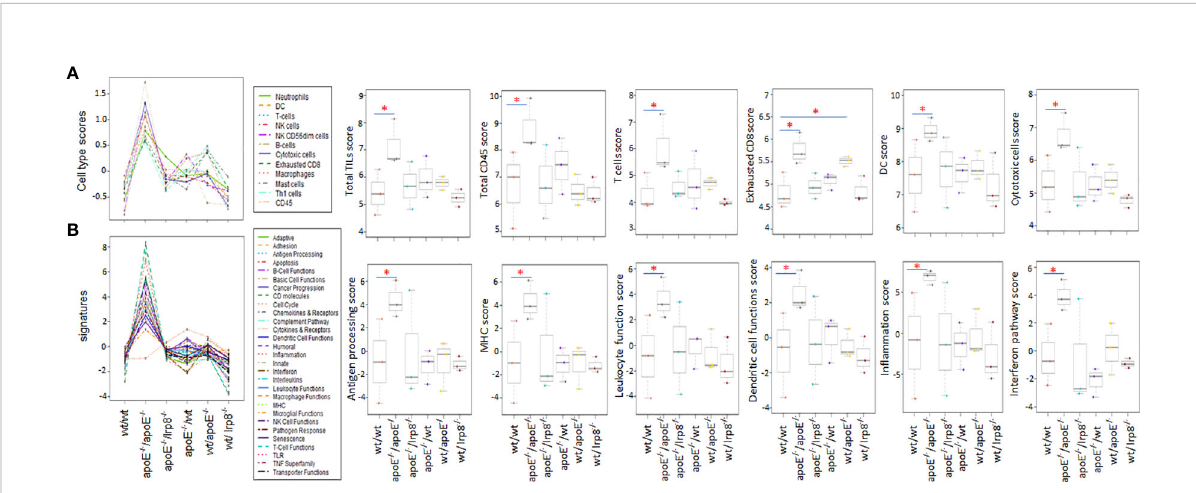
FIGURE 7 The fi rst three tumors that reached 15mm in each of the experimental groups were harvested and the immune cell in fi ltrate and immune pathway activation was analyzed with nanostring Pancancer immune pro fi ling. (A) Immune cell type scores and (B) immune pathway (signature) scores show that immune cell in fi ltrates and immune pathway activation were greatest when apoE-/- cells were injected into apoE-/- mice. Dot line plots show the score trends of 12 immune cell lines and 29 immune pathways. Box plots show selective representative score comparisons. Results are expressed as mean score ±SD. *p<0.05, determined by unpaired two-tailed Student ’ s t-test. Wt/wt: wt B16 cells injected in wt mice; apoE-/-/apoE-/-: apoE-/- cells injected in apoE-/- mice; apoE-/-/lrp8-/-: apoE-/- cells injected in lrp8-/- mice; apoE-/-/wt: apoE-/- cells injected in wt mice; wt/apoE-/-: wt cells injected in apoE-/- mice; wt//lrp8-/-: wt cells injected in lrp8-/-